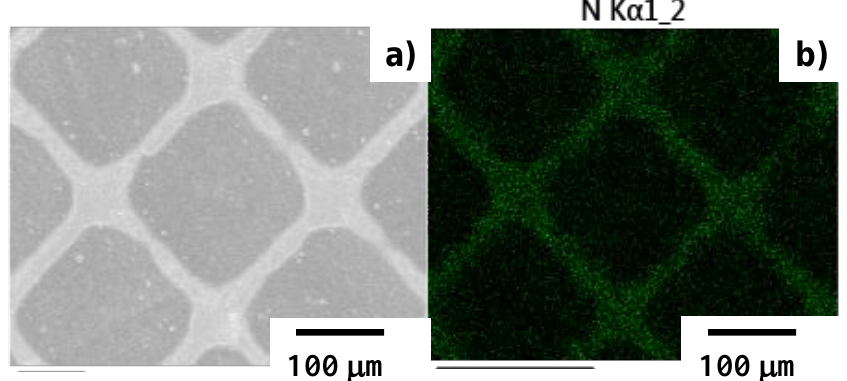
Figure 7. Microstructure of plasma-nitrided AISI316 die surface at 673 K for 14.4 ks. ( a ) SEM image and ( b ) nitrogen mapping by EDX.